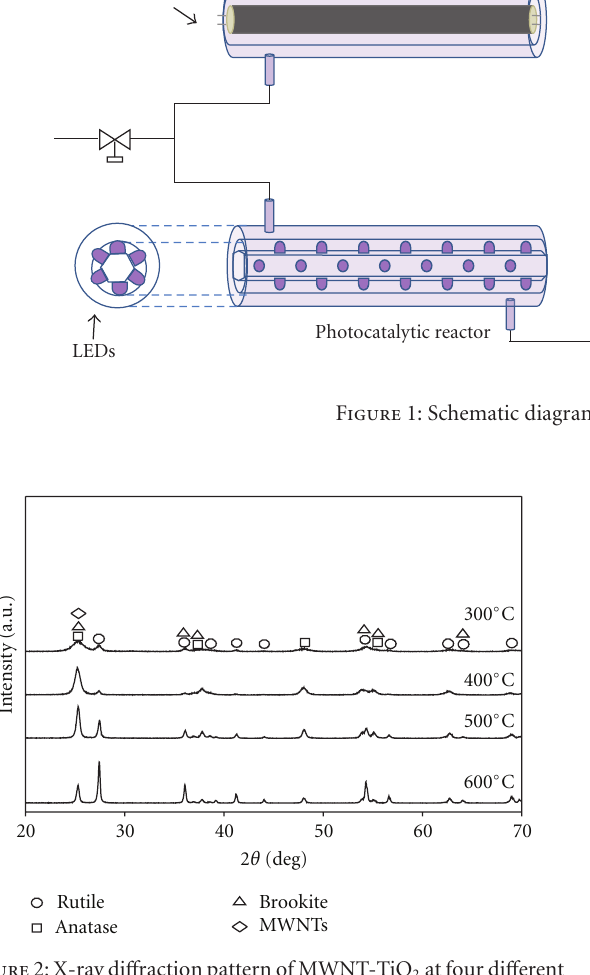
Figure 2: X-ray di ff raction pattern of MWNT-TiO 2 at four di ff erent calcination temperatures (300, 400, 500, and 600 ◦